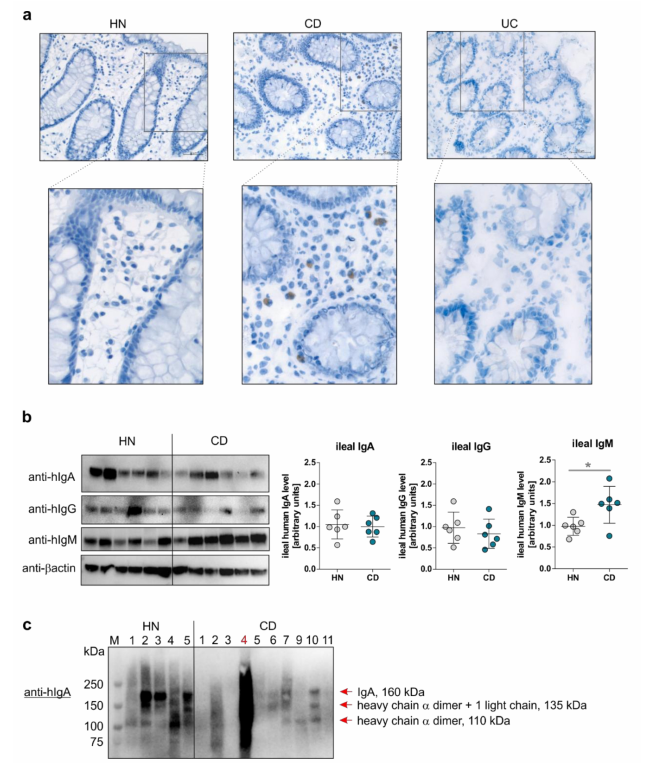
Figure 4. Intestinal naïve memory B cells are highly present in CD patients in remission. ( a ) CR2 protein level in colonic biopsy samples from HN or CD, as well as UC patients in remission, was determined by immunohistochemistry (IHC) analysis. Representative pictures are presented (original magnification: 20 × ). ( b ) Western blot analyses of immunoglobulin alpha (IgA), human immunoglobulin gamma (IgG), or immunoglobulin M (IgM) expression in ileal biopsy samples from HN (n = 6) or CD patients in remission (n = 6). Western blot analysis of β -Actin served as a loading control (left panel). Densitometric analysis of whole hIgA, hIgG, or hIgM protein expression utilizing the software ImageJ (right panel). Mean ± SEM values are depicted. * p ≤ 0.05. ( c ) Western blot analysis of hIgA expression in fecal samples from HN (n = 5) or CD patients in remission (n = 11; CD patient #4 is in active